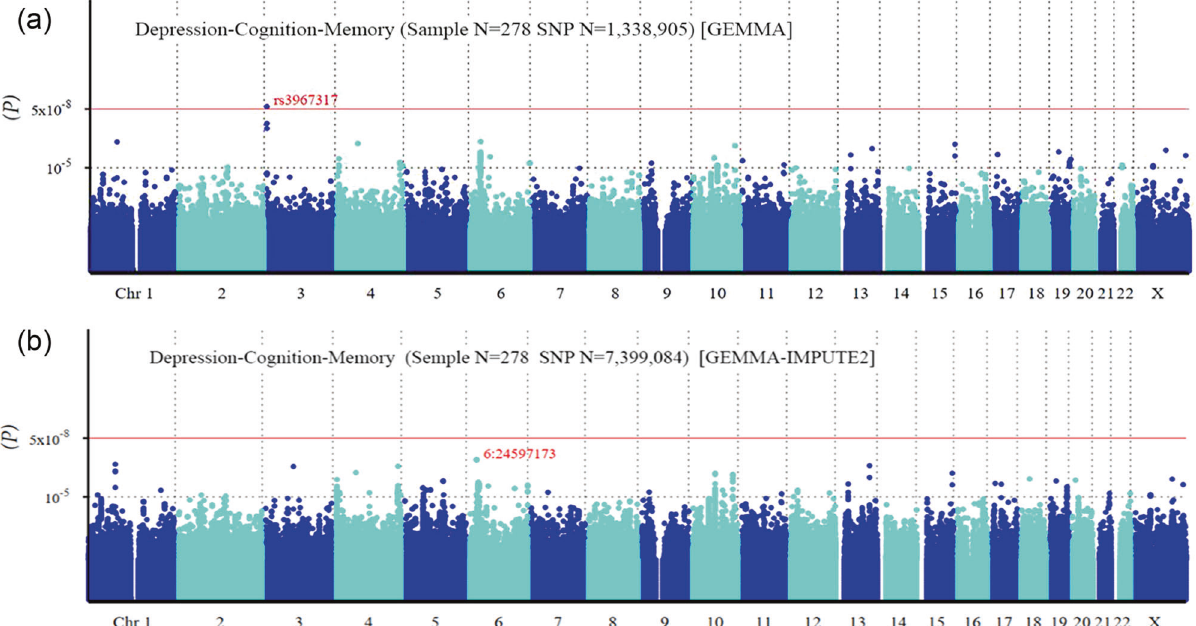
Fig. 3 Manhattan plot for multivariate genome-wide association study of depression-cognition-memory. a The Manhattan plot based on data before imputation. b The Manhattan plot based on data after imputation. The horizontal axis represents autosomes and the X chromosome, while the vertical axis represents the P values of SNPs. The red line represents the genome-wide signi fi cance threshold (5 × 10 − 8 ), and the lower horizontal dashed line represents the suggestive signi fi cance level (1 × 10 − 5